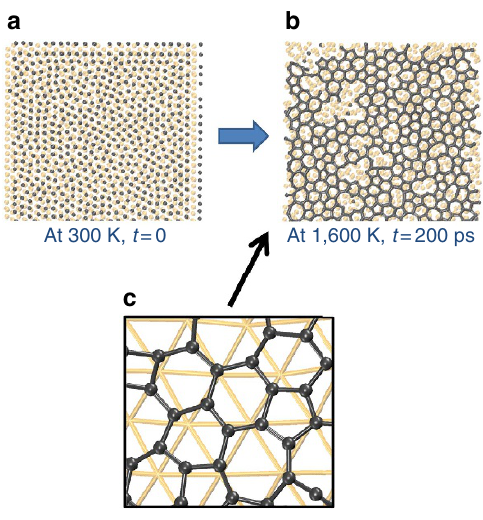
Figure 9 | Growth of graphene film on Ni (111) surface. Growth of uniform graphene film on Ni (111) surface is highlighted. ( a ) Initially, amorphous carbon is placed on Ni (111) film. ( b ) After heating up to 1,600K for 200ps formation of ordered graphene rings on the nickel surface is observed with ( c ) high-magnification image indicating lattice configuration of graphene on nickel. Carbon atoms are represented by dark grey colour, while nickel atoms by pale orange